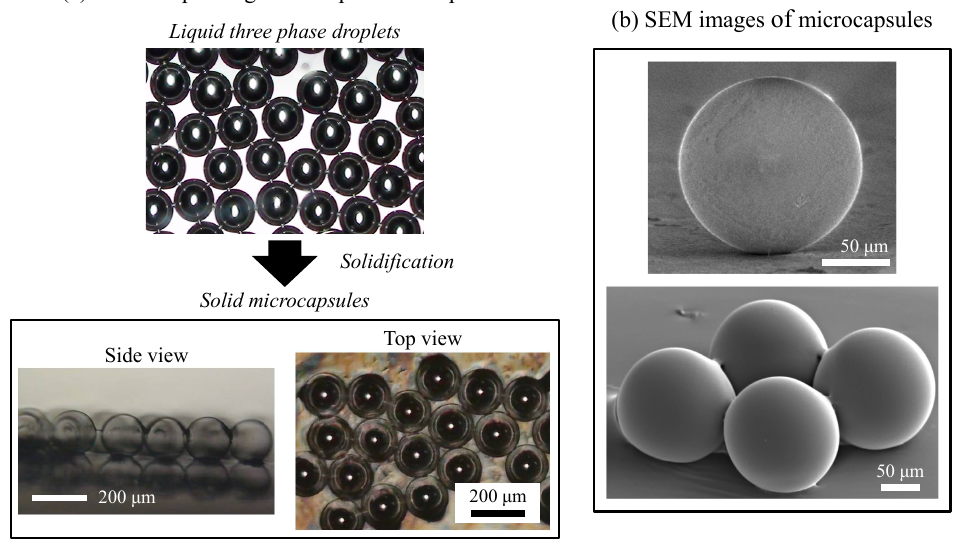
Figure 5. Images of solidified